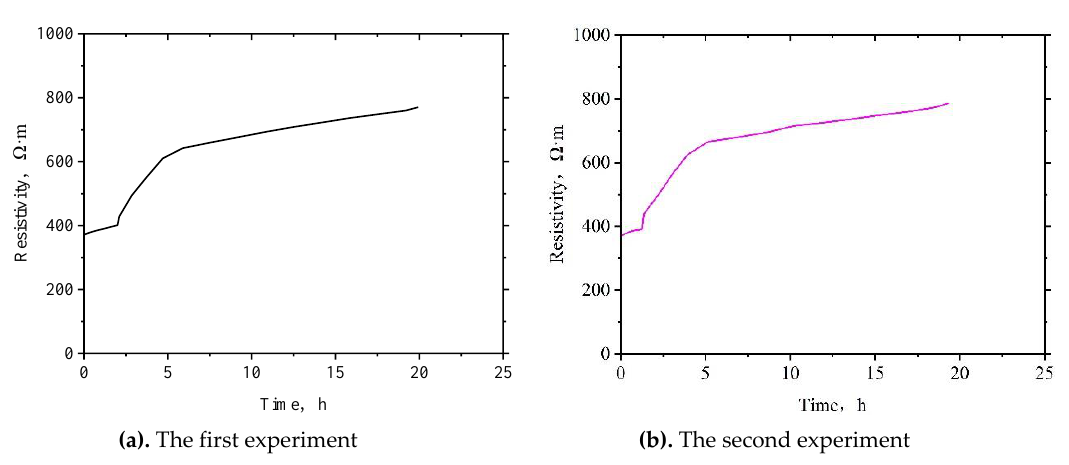
Figure 14. Temperature and pressure changes during preparation of hydrate by three-in-one method.